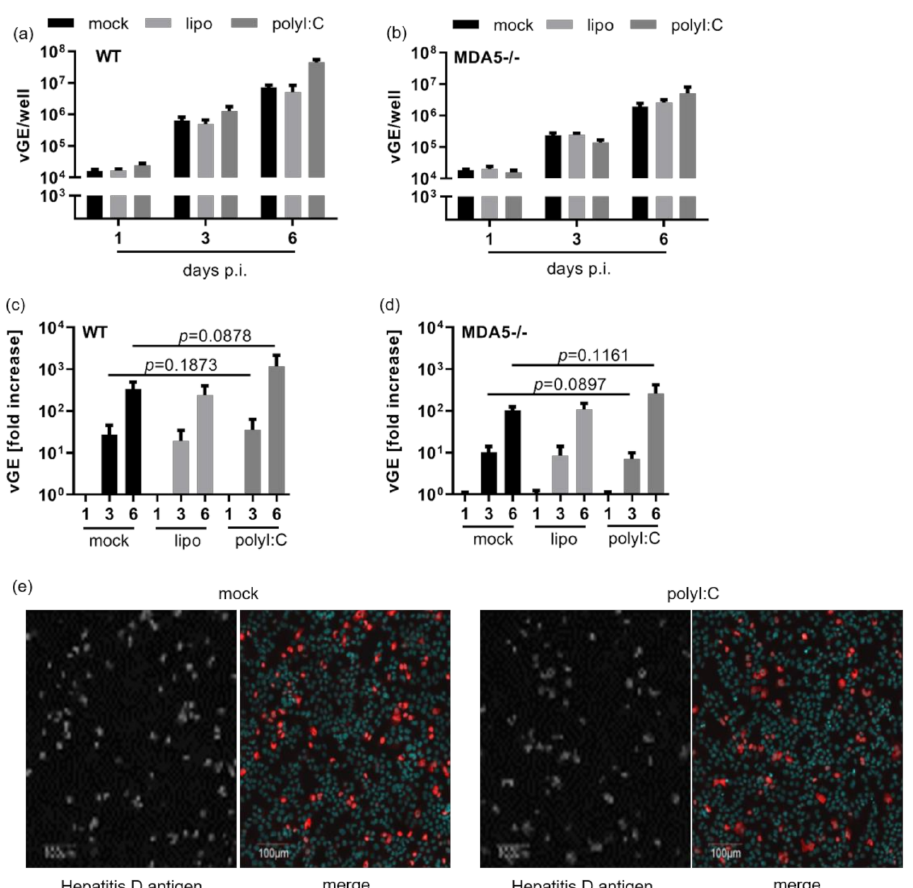
Figure 4. Type I interferon does not impair HDV replication. Both WT ( a , c ) and knock-out MDA5-/- ( b , d ) cells were seeded in a 24-well plate, stimulated with 100 ng/mL poly I:C using lipofectamine as control or left untreated (mock) and infected with HDV at an MOI of 20 vp/cell 6 h post treatment. RNA was extracted at 1, 3 and 6 dpi and vGE/well were quantified by qRT-PCR. ( a , b ) Absolute numbers of vGE/well detected in infected cells. Bars represent one single experiment with biological triplicates each. ( c , d ) Graphs depict the fold-increase in viral vGE over time relative to day 1. Bars comprise five data points per group from two independent experiments. Data were analysed for normality distribution using Kolmogorov–Smirnov test; statistical analysis of the normally distributed data was done using paired t -tests. ( e ) Exemplary HDAg immunofluorescence staining 7 dpi. Scale bars 100 µ